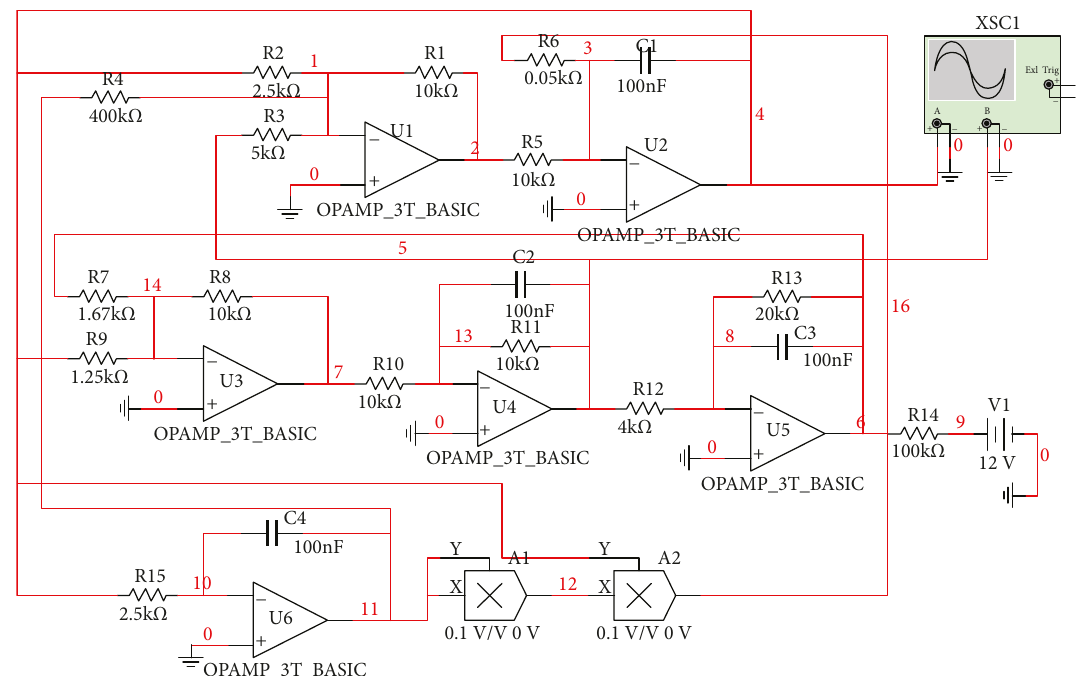
Figure 10: The novel memductor-based chaotic circuit with